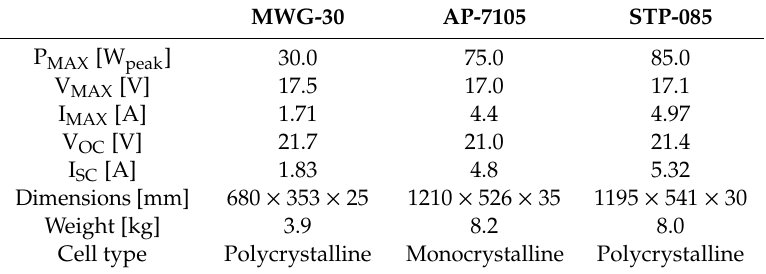
Table 1. Datasheet of photovoltaic (PV) modules tested inside the laboratory hall: MWG-30, AP-7105, and STP-0852.